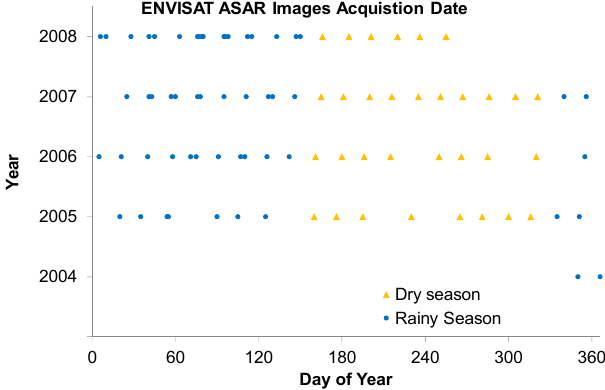
Figure 2. Acquisition dates of ENVISAT ASAR images in GM mode over the Guayas Basin between December 2004 and September 2008 for dry (orange squares) and rainy (blue dots) seasons. These images were made available by ESA through the EOLi (Earth Observation Link) Earth Observation Catalogue and Ordering Services [32].